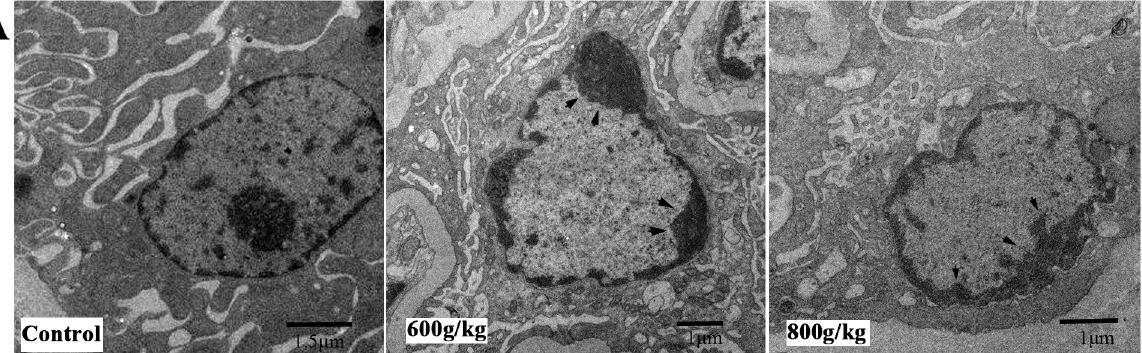
Fig 6. Ultrastructural morphology changes of renal cells. (A) Saanen goats were administrated with various doses of E . adenophorum for 3 months, and the ranal cells of saanen goats were conducted with ultrastructural observation. After a series of washing, fixation, dehydration and stained, cells were visualized under transmission. Magnification,